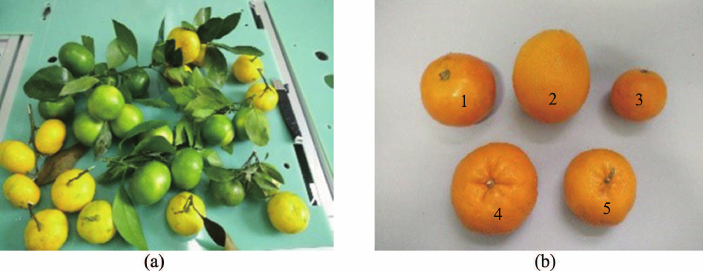
Figure 9. Six varieties of citrus fruits: ( a ) Jiangxinzhou tangerine; ( b ) 1. Gannan navel orange; 2. Egyptian orange; 3. Yunnan crystal sugar orange; 4. Sichuan ugly orange; 5. Yongchun ponkan.